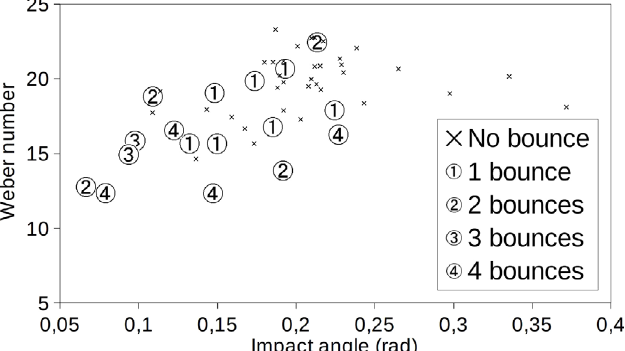
Fig. 7. Weber number against impact angle for a sample of drops. The velocity and size of each drop were determined thanks to the records obtained from a FLARE 2M360 MCL high frame camera and numerical measurements. Uncertainties of 20% on the Weber number and ±0.02rad on the impact angles have to be considered.